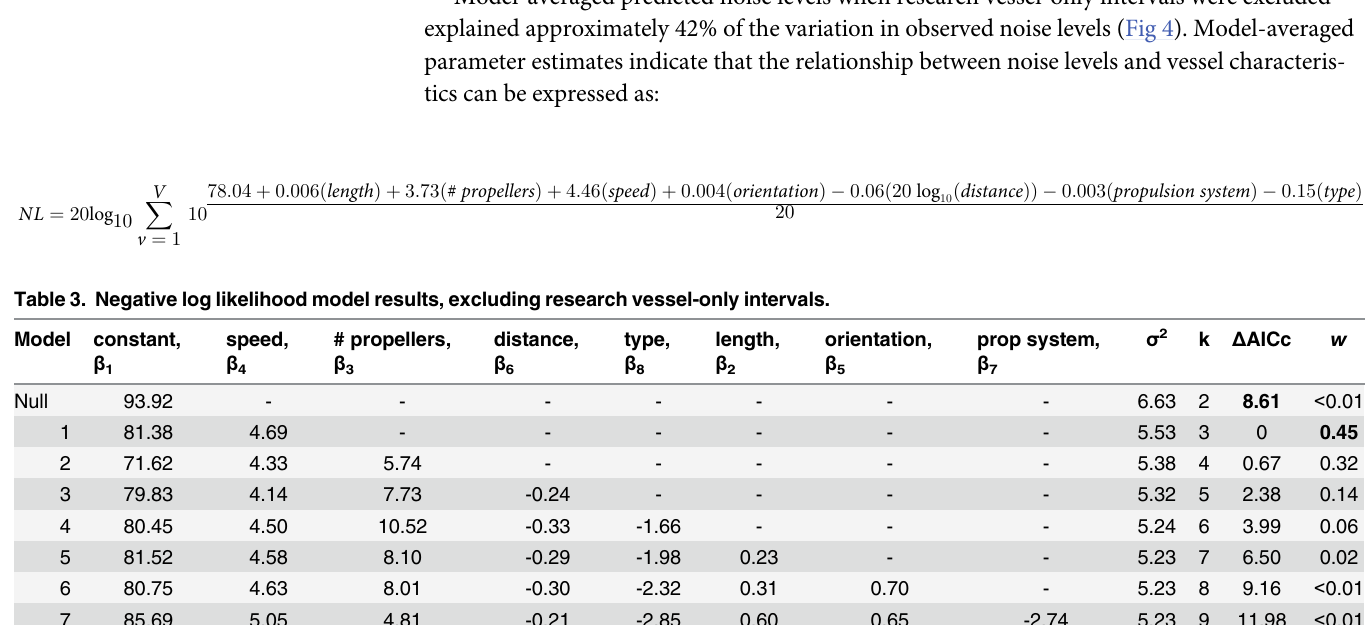
Results of the negative log likelihood model (excluding research vessel-only intervals, n = 30). Model parameters are the vessel characteristics that contribute to received noise. The model that best fi t the data was model 2. However, models with additional parameters also had an adequate amount of weight but due to the nature of AICc, could represent uninformative